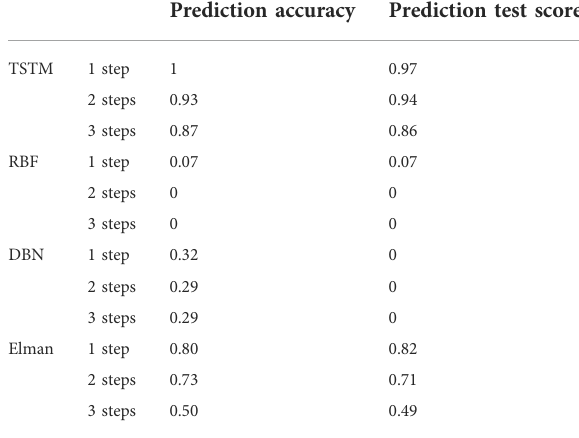
TABLE 2 Performance of four models for heavy pollution weather forecast in